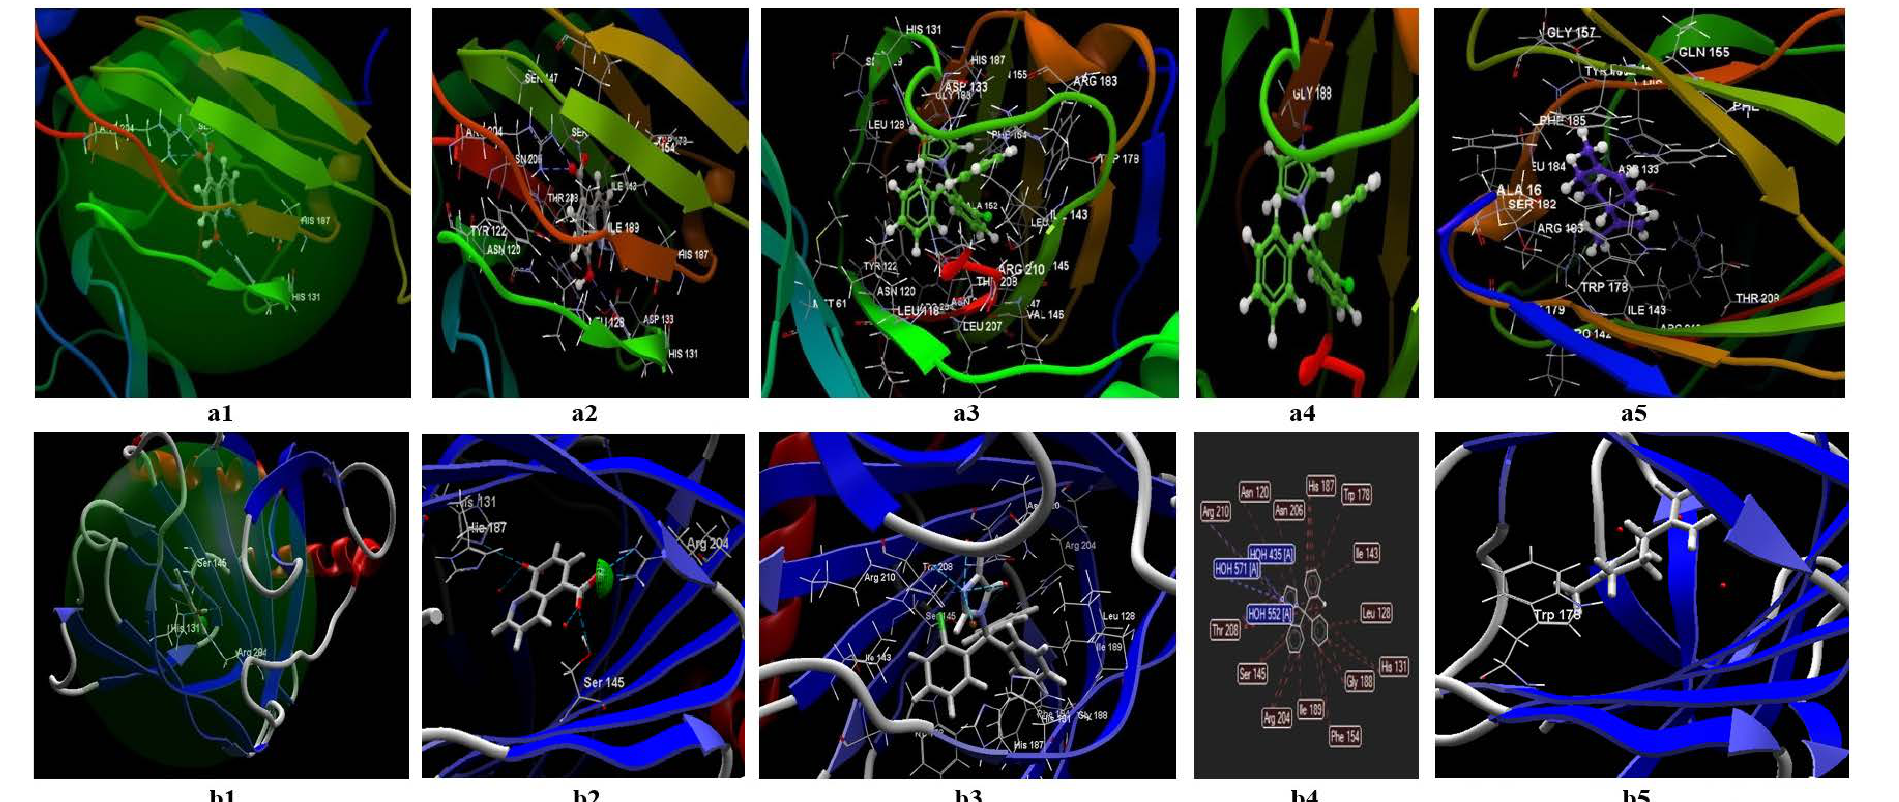
Figure 10. Molecular docking of the co-crystallized 8XQ, limonene, and clotrimazole for E. coli in the binding site 4JHT. ( a1 ) Docking of the co-crystallized 8XQ in the binding site 4JHT generated by CLC); ( b1 ) docking of the co-crystallized in the binding site 4JHT, generated by MOLEGRO); ( a2 ) docking of the co-crystallized 8XQ, hydrogen bonds, and interactions with amino acid residues from the binding site 4JHT, generated by CLC; ( b2 ) hydrogen bonds, electrostatic interactions, and steric interactions between the co-crystallized 8XQ and the amino acids from the binding site 4JHT, in 3D model generated by MOLEGRO; ( a3 ) interactions between clotrimazole and the amino acid residues from the binding site 84JHT, generated by CLC; ( b3 ) hydrogen bonds and steric interactions between clotrimazole and the amino acids from the binding site 4JHT, generated with MOLEGRO; ( a4 ) the hydrogen bonds (blue dotted lines) between clotrimazole and SER 49, in the binding site 4JHT, generated by CLC; ( b4 ) the hydrogen bonds (blue) and steric interactions (red) between clotrimazole and the amino acids from the binding site 4JHT, 2D model generated by MOLEGRO; ( a5 ) the interactions of limonene with the amino acid residues from the binding site 4JHT, generated by CLC; ( b5 ) the interactions of limonene with the amino acid residues from the binding site 4JHT, generated by